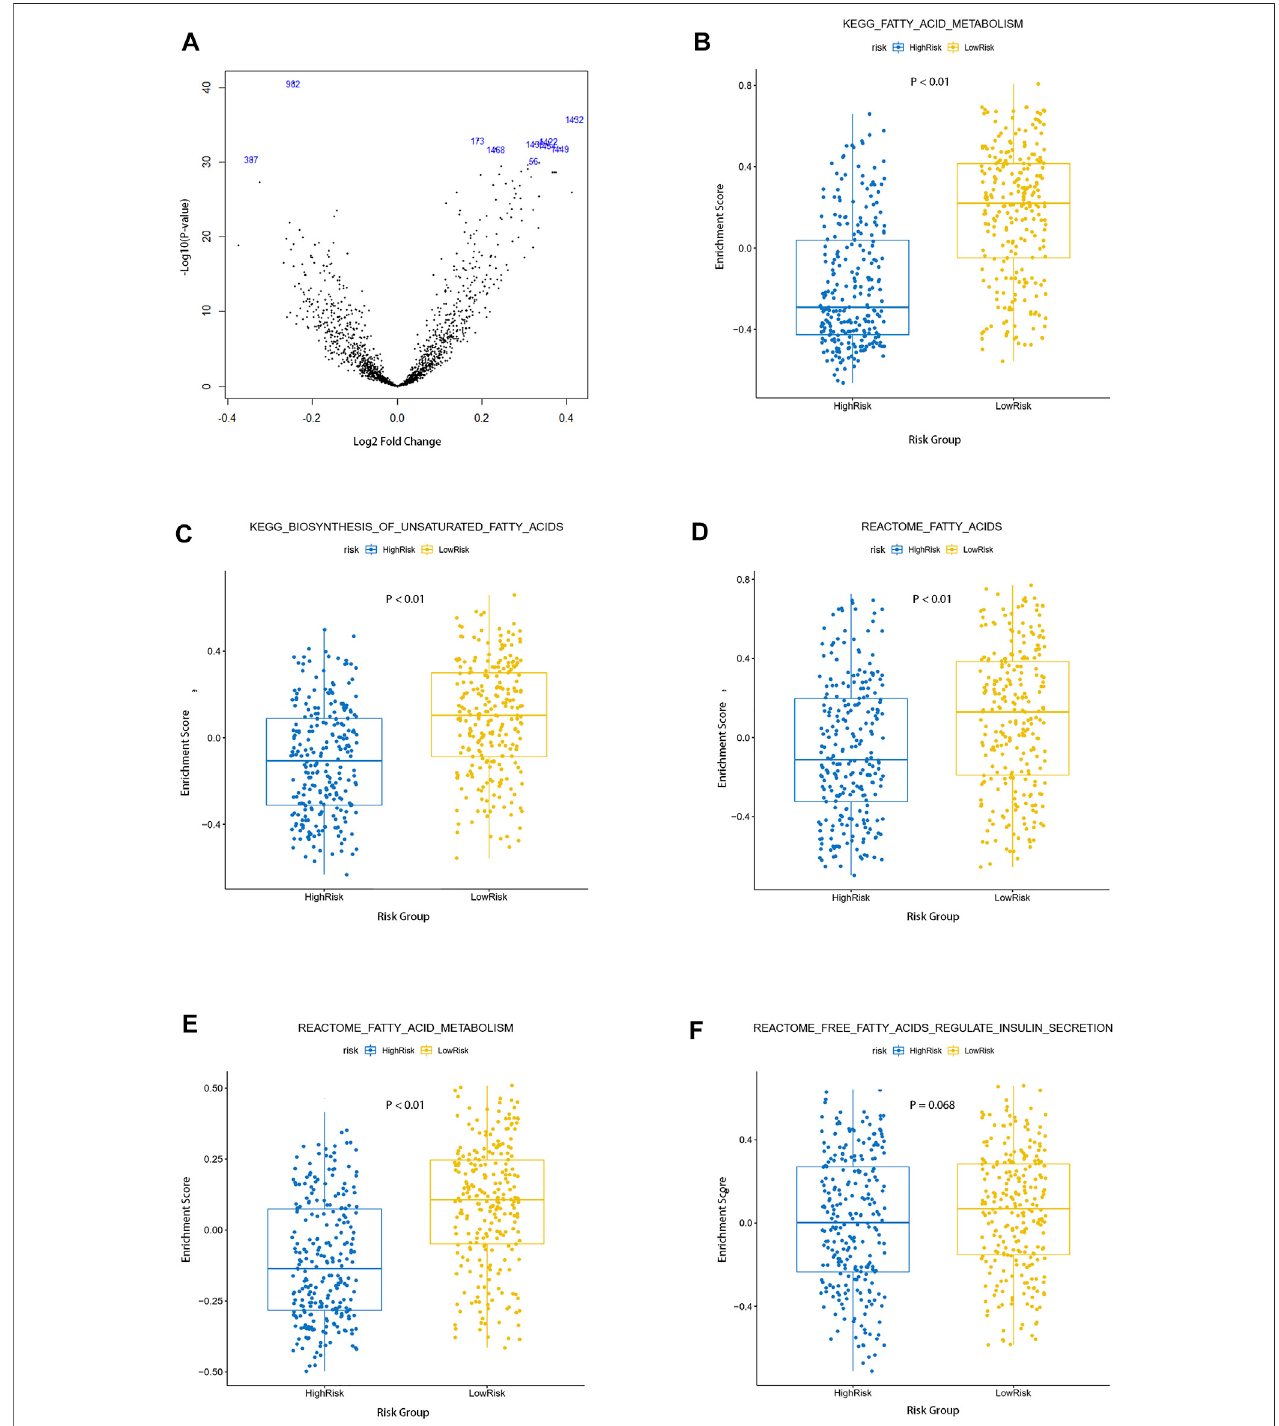
FIGURE 4 | Single sample gene set variation analysis of fatty acid metabolism pathways between the two groups. (A) Volcano map of differential pathways between the two groups (B – F) Enrichment of fi ve fatty acid metabolism – related pathways in the two groups.